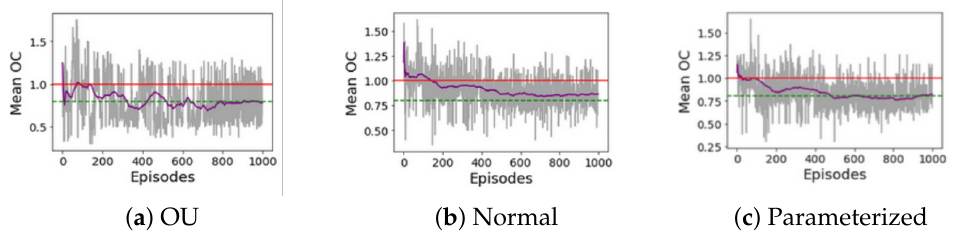
Figure 4. Mean occupancy count per episode for the DDPG implementations. ( a ) Ornstein–Uhlenbeck noise, ( b ) normal distribution noise, and ( c ) parameter noise. The purple line shows the trend, the red line represents the sustained capacity, and the green line represents 80% of the sector’s